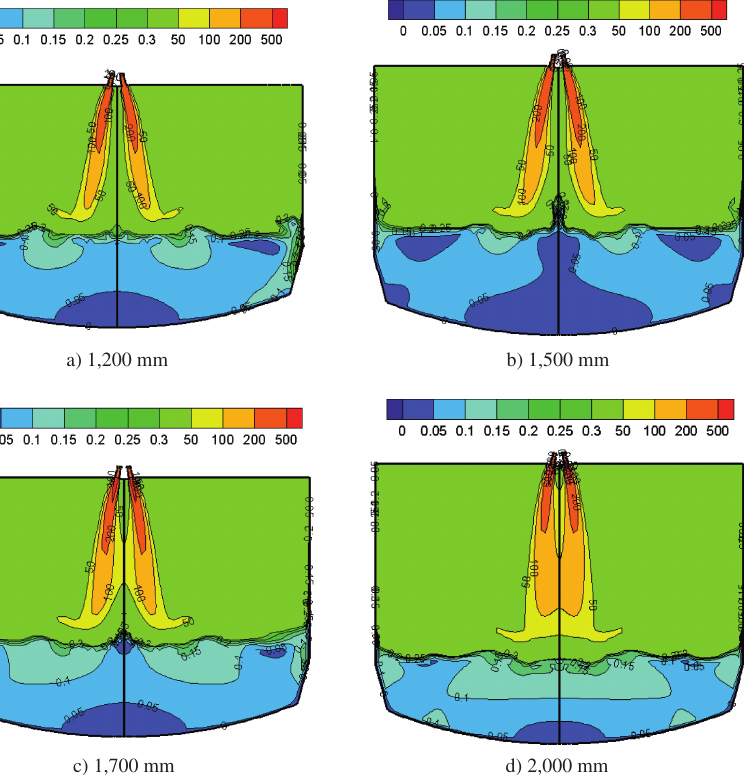
Figure 7: Converter ’ s velocity contour map of vertical section at different lance height.